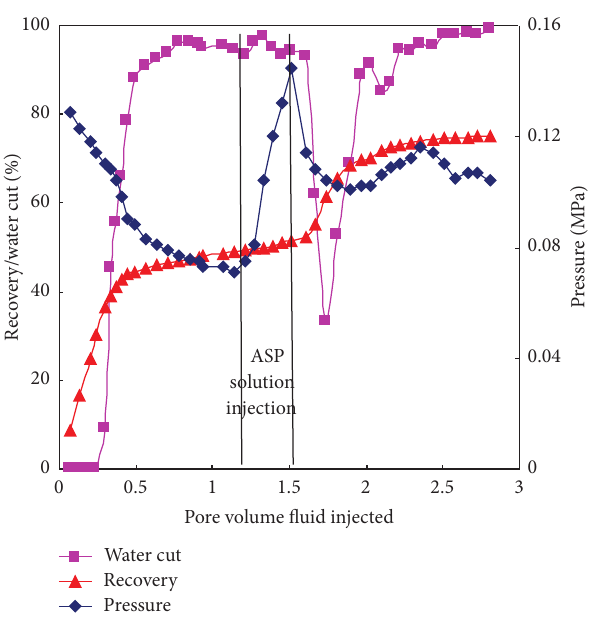
Figure 8: Flooding curve of the ASP flooding system. Figure 9: Viscosity-concentration curves of four flooding systems (in on-site injection water).